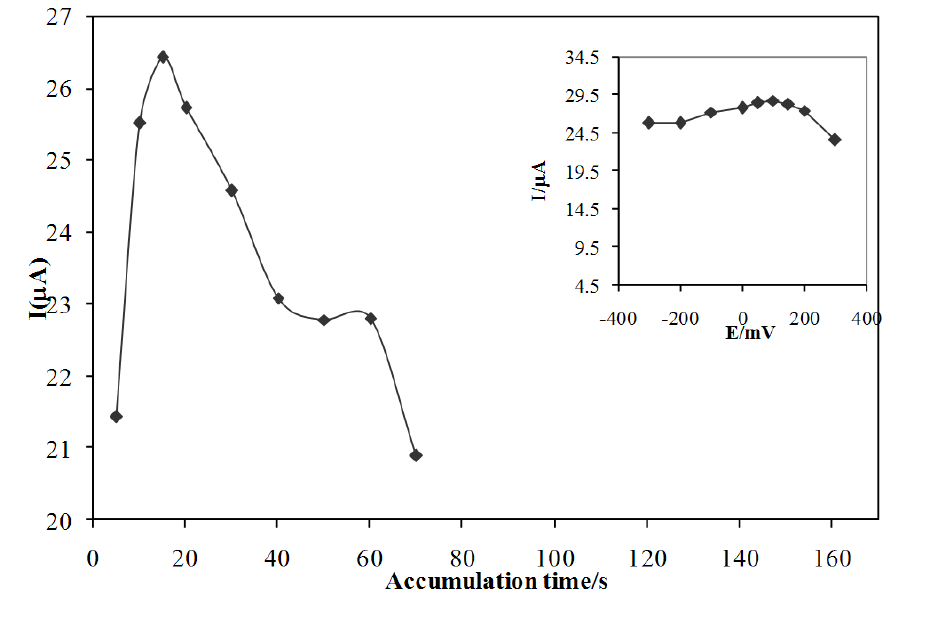
Figure 6. Effect of the accumulation time on the peak current in the presence for diclofenac solution a) 1.0 × 10 − 8 M and at inst figure: 5.0 × 10 − 7 M at acetate buffer pH = 4. E = 0.1 V., ƒ = 600 Hz., amplitude(cid:31) = 50 acc.